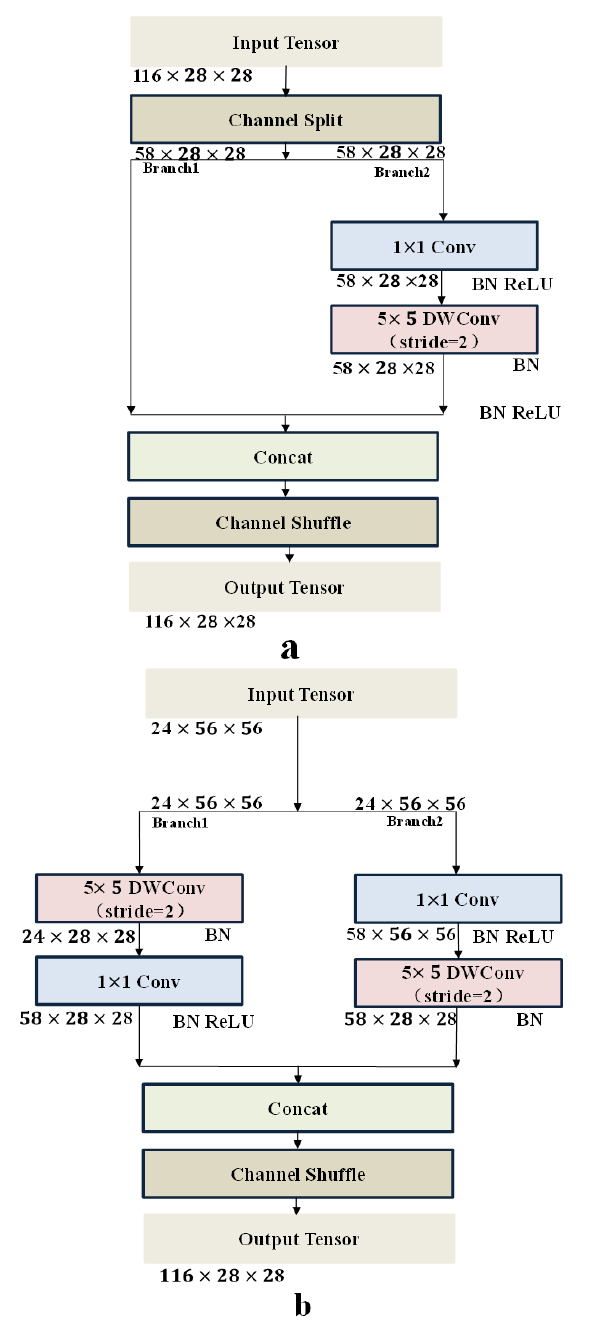
Figure 5. Structure of the compression block. ( a ) basic compression block unit and ( b ) basic compres- sion block unit for spatial